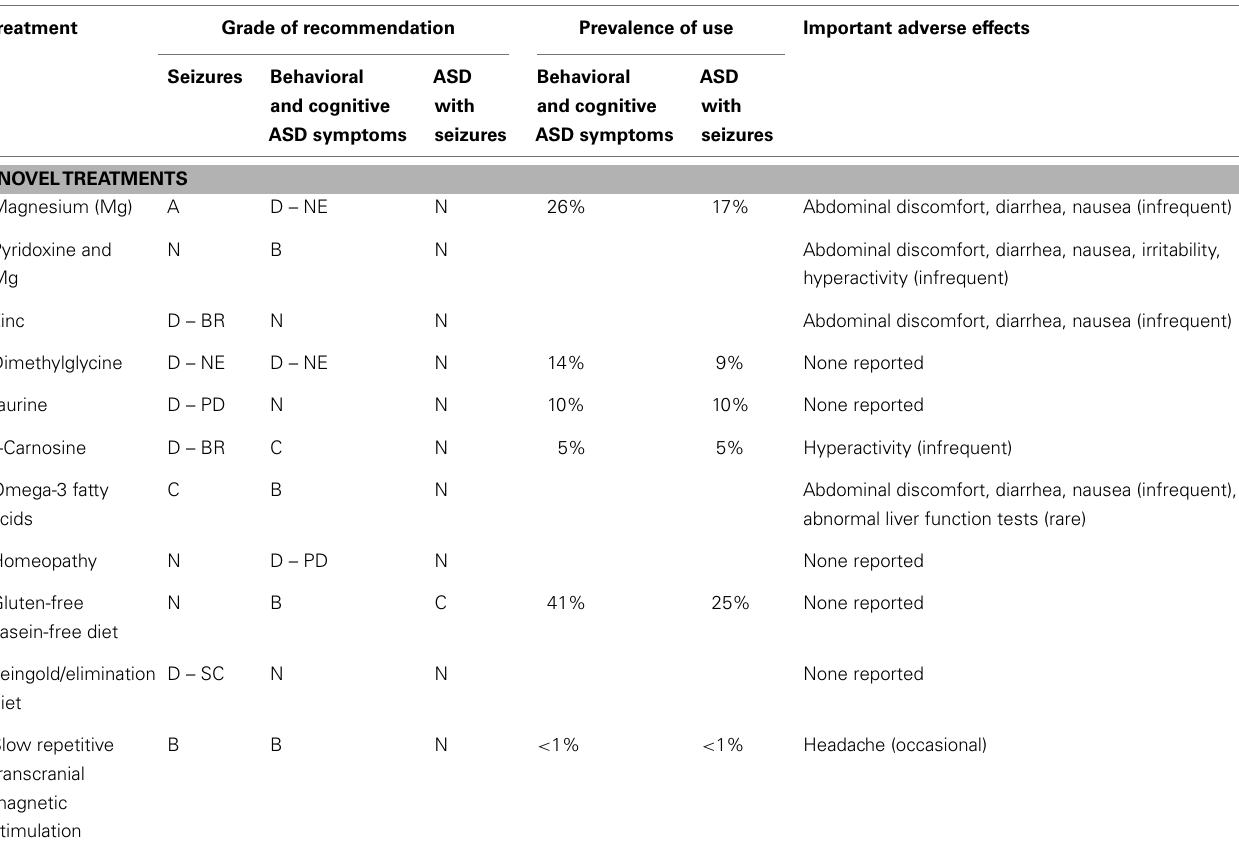
FIGURE 1 | Seizure survey rating for the most favorable rated anti-epileptic drug treatments for clinical seizures .The perceived effect on seizures was not different across the four anti-epileptic drug